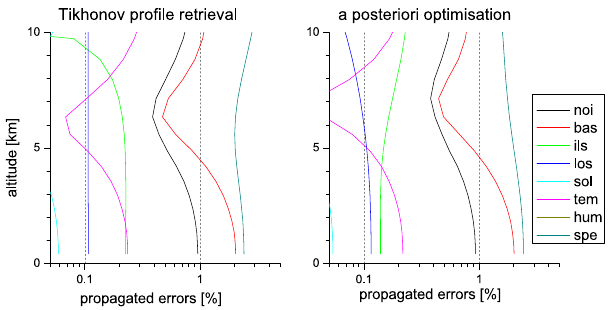
Figure 6. Error propagation for CH 4 due the uncertainties as listed in Table 2 in the third column. Error sources as given in the leg- end: noi (measurement noise), bas (baseline), ils (instrumental line shape), los (line of sight), sol (solar lines), tem (atmospheric tem- perature), hum (cross-dependency on humidity; this error is smaller than 0.02%), and spe (spectroscopic parameters). Left panel: for the Tikhonov–Phillips profile retrieval. Right panel: after applying the a posteriori